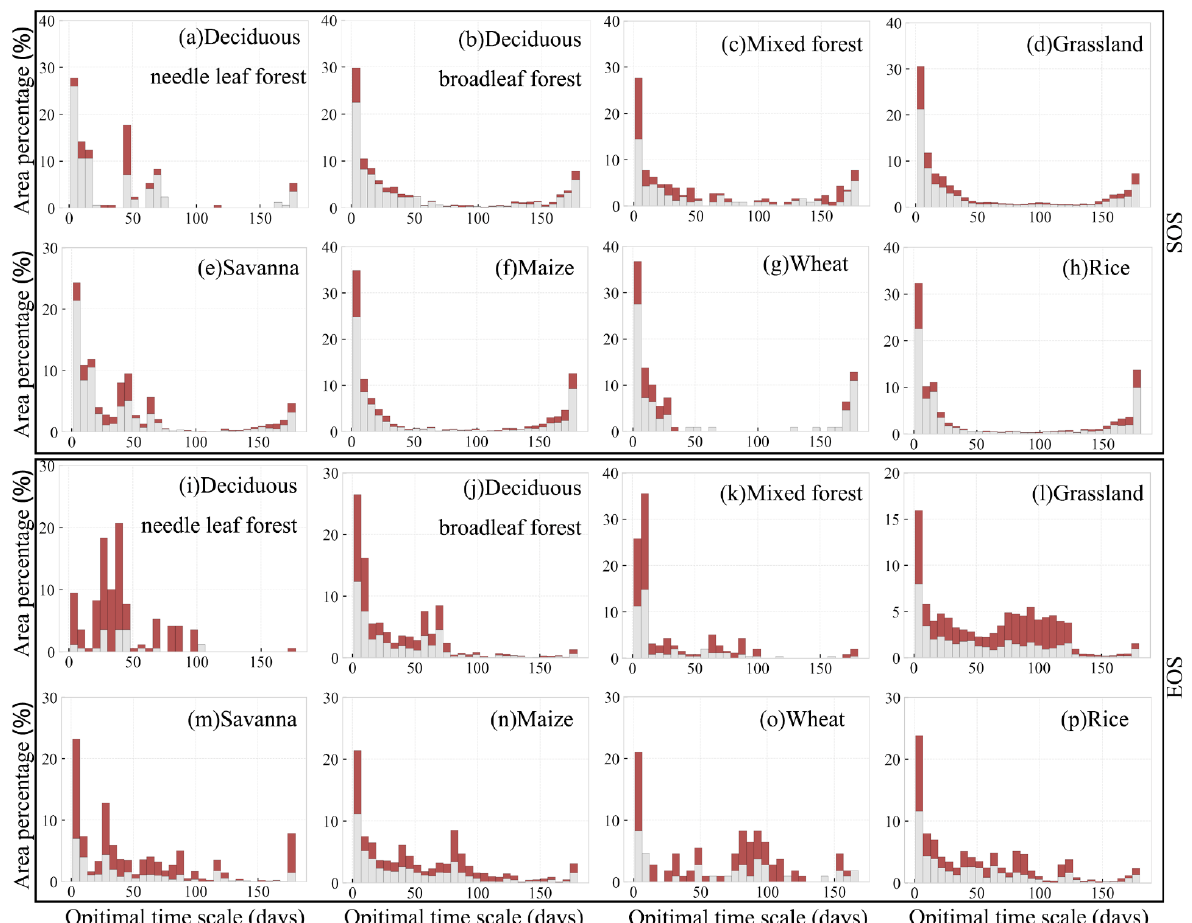
Figure 11. ( a – h ) Histograms of the optimal time scale of different land-use types for SOS vs. preseason precipitation, and ( i – p ) for EOS vs. preseason precipitation. Red part means p -value < 0.05, while gray means p -value ≥ 0.05.